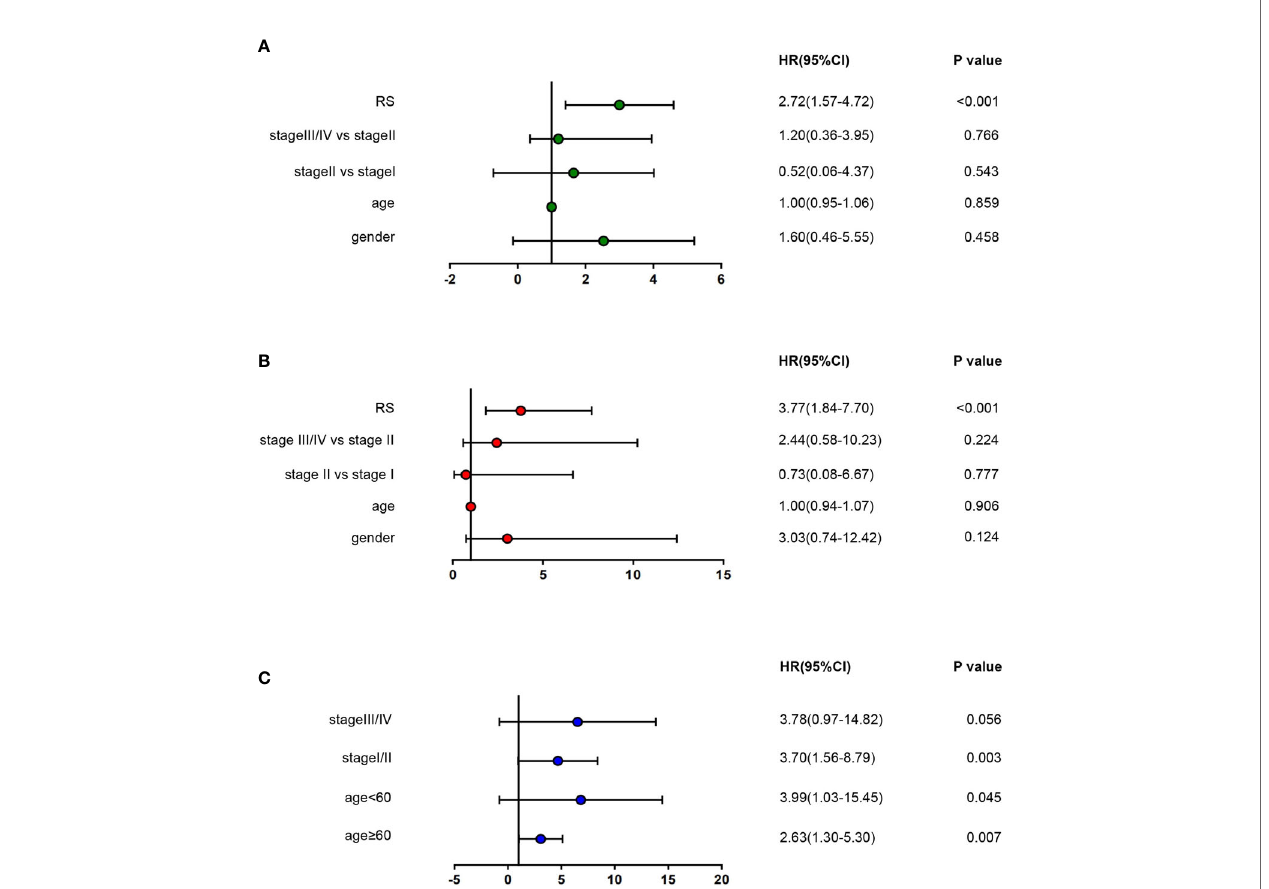
FIGURE 6 | Cox regression analyses of the association between clinicopathological factors and overall survival (OS). (A, B) Univariate/multivariate Cox regression analyses of clinicopathological factors(including RS) and OS of patients in TCGA. (C) Univariate Cox regression analyses of RS and OS indifferent clinicopathological